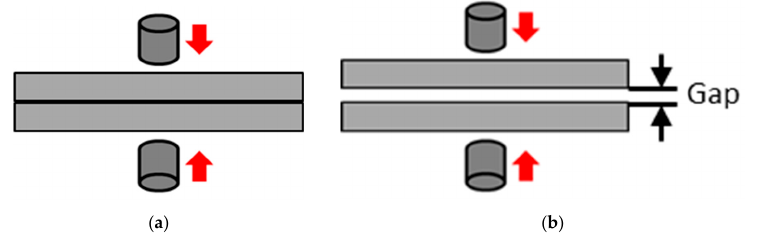
Figure 2. Gap between work-pieces. ( a ) Ideal; ( b ) In real.